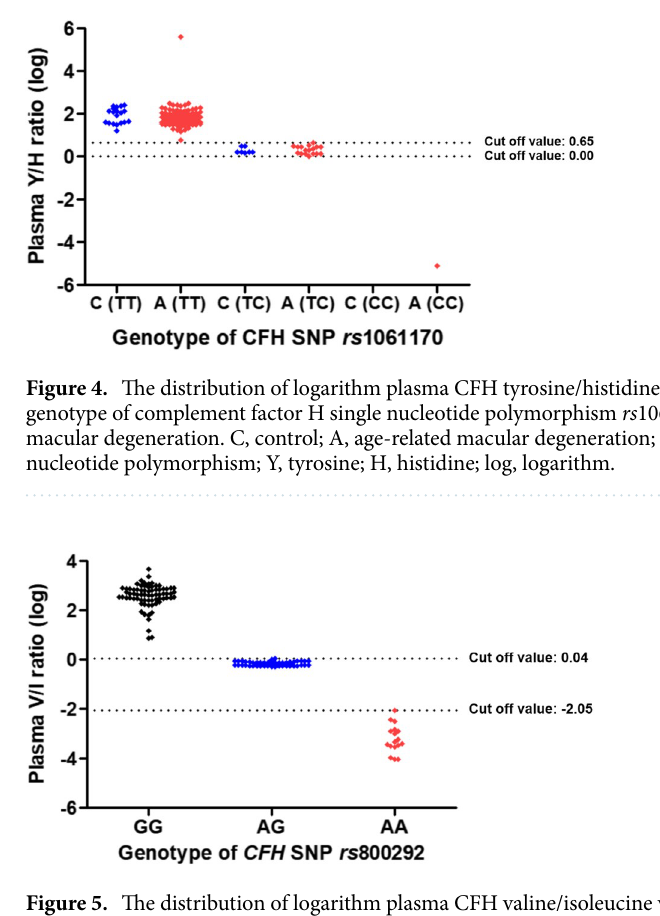
Figure 5. The distribution of logarithm plasma CFH valine/isoleucine varinat protein ratio according to the genotype of complement factor H single nucleotide polymorphism rs 800292. CFH, complement factor H; SNP, single nucleotide polymorphism; V, valine; I, isoleucine; log,